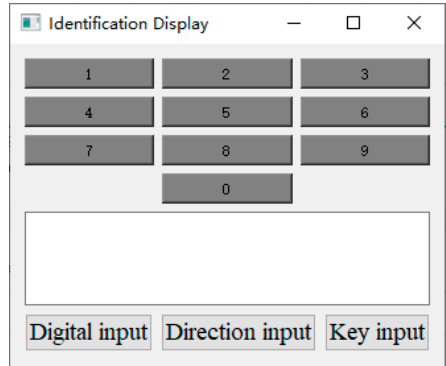
Figure 6. Chip window of the application.